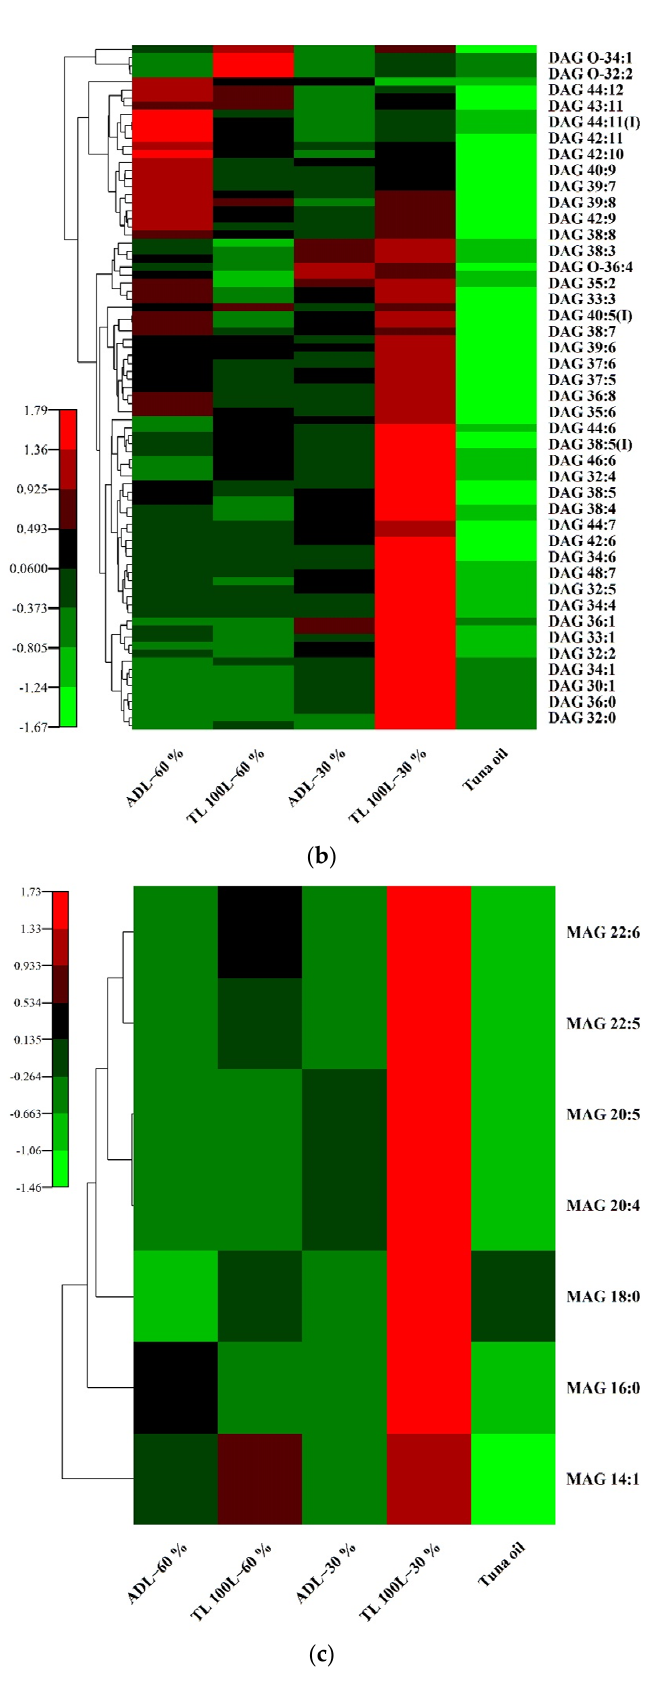
Figure 3. Cluster heat map of three kinds of acylglycerols. ( a ) Cluster heat map of TAG; ( b ) Cluster heat map of DAG; ( c ) Cluster heat map of